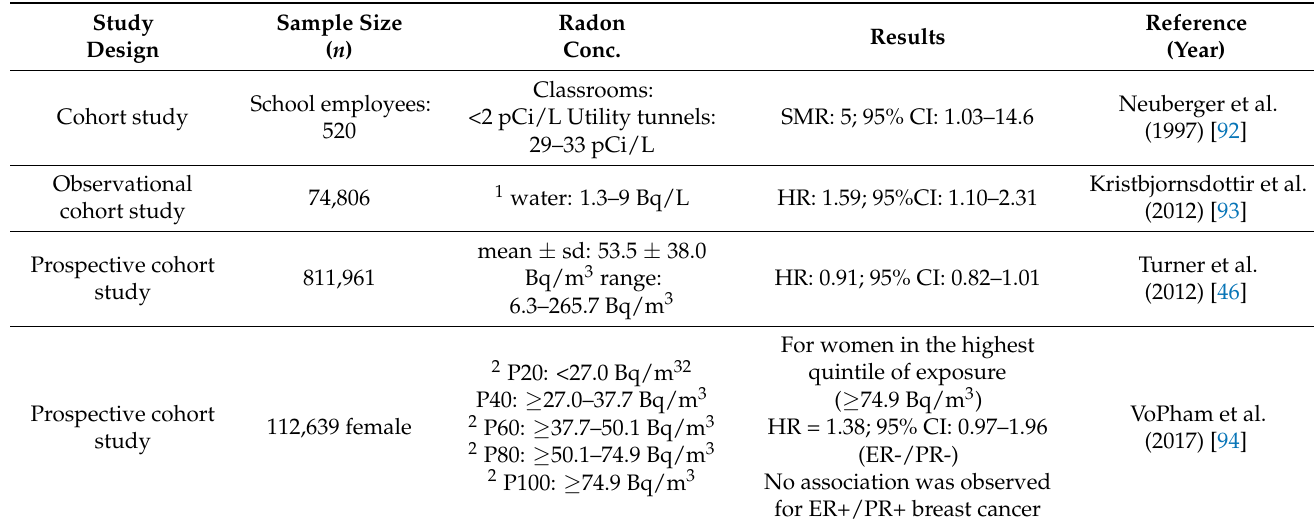
Table 6. Breast cancer: Workers and general